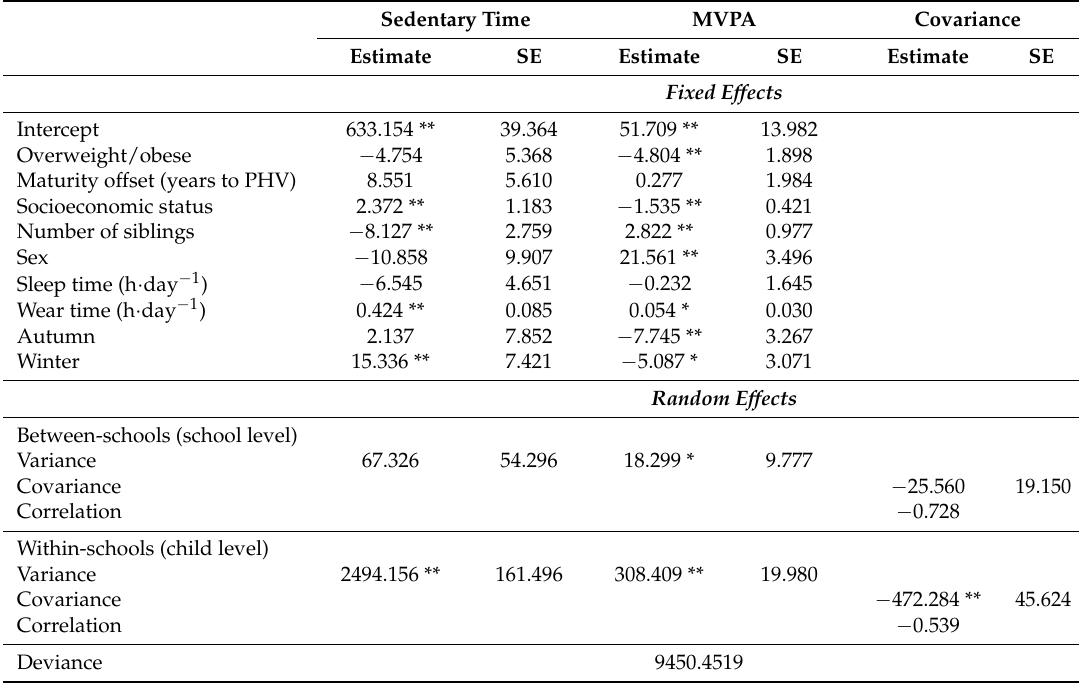
Table 4. Model 2 (parameter estimates, Standard Errors (SE), and deviance) including child level predictors for both sedentary time and MVPA.